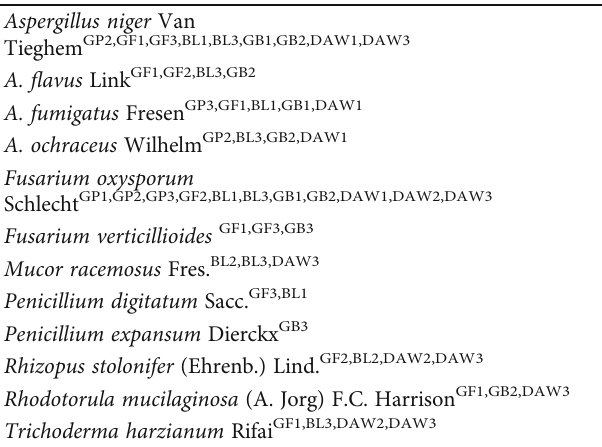
Table 3: Pooled data of total fungi isolated from ginger, dawadawa, bay leaf, and